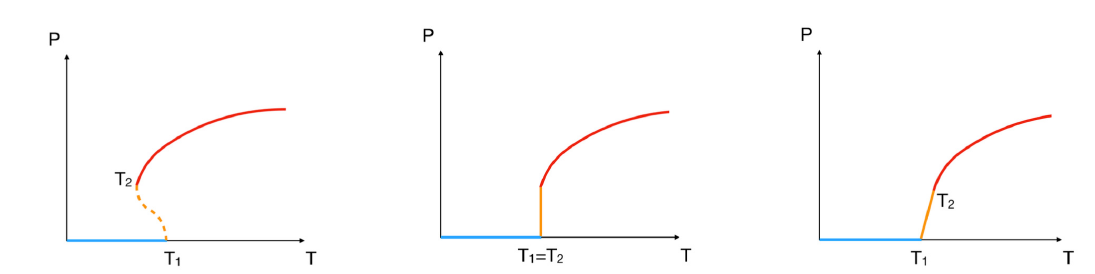
Figure 2. Typical shapes of confinement/deconfinement phase transition line in large- N gauge theories. The solid and dashed lines are minimum and maximum of the free energy at each fixed temperature. Similar plots can be drawn by taking the vertical axis to be the energy E instead of the Polyakov loop P . (This figure appeared originally in ref.